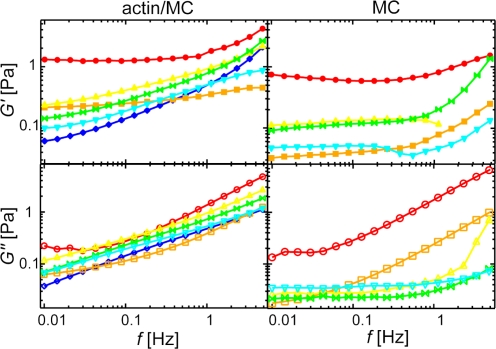
Viscoelastic response of MC and actin/MC solutions.Frequency spectra of storage (upper panel, closed symbols) and loss moduli (lower panel, open symbols) of MC solutions with (left) and without (right) 9.5 µM F-actin. The symbols represent increasing c
MC: 0% (w/v) blue diamonds, 0.01% light blue downright triangles, 0.1% green butterflies, 0.2% yellow upright triangles, 0.5% orange squares and 1% red circles. G′(f) and G″(f) of actin/MC solutions increase with increasing MC concentration for c
MC≤0.2% (w/v), the critical concentration.